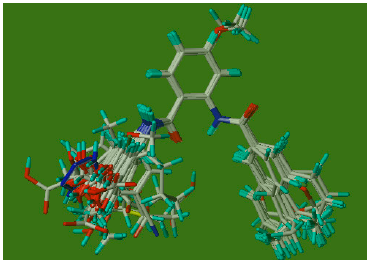
Figure 7. Alignment of training and test set compounds on compound 30. Baby blue, red, blue, green, gray and yellow signify hydrogen atom, oxygen atom, nitrogen atom, fluorine atom, carbon atom and sulfur atom, respectively.